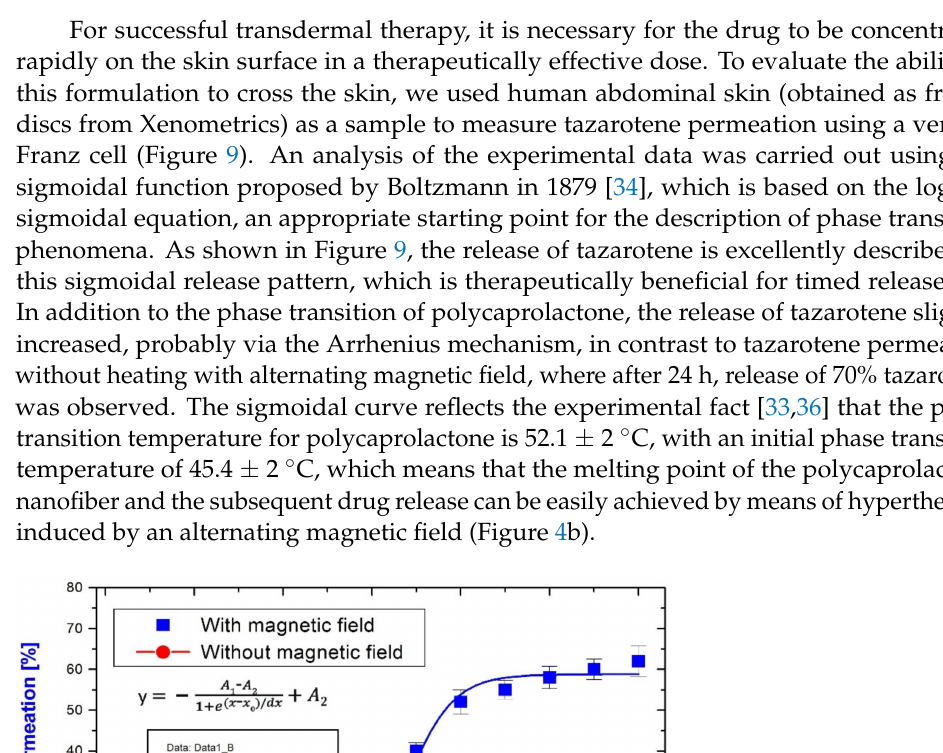
Figure 8. Colorimetric assay of magnetic nanoparticles in nanofiber patch: ( a ) optical microscopy image of patch without Prussian blue; ( b ) patch immediately after staining when Prussian blue crystals are formed.